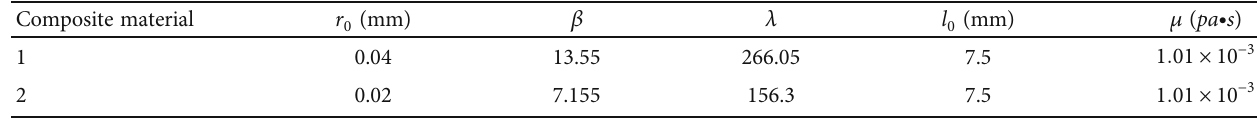
Table 3: Design parameters of in fi ltration grouting.